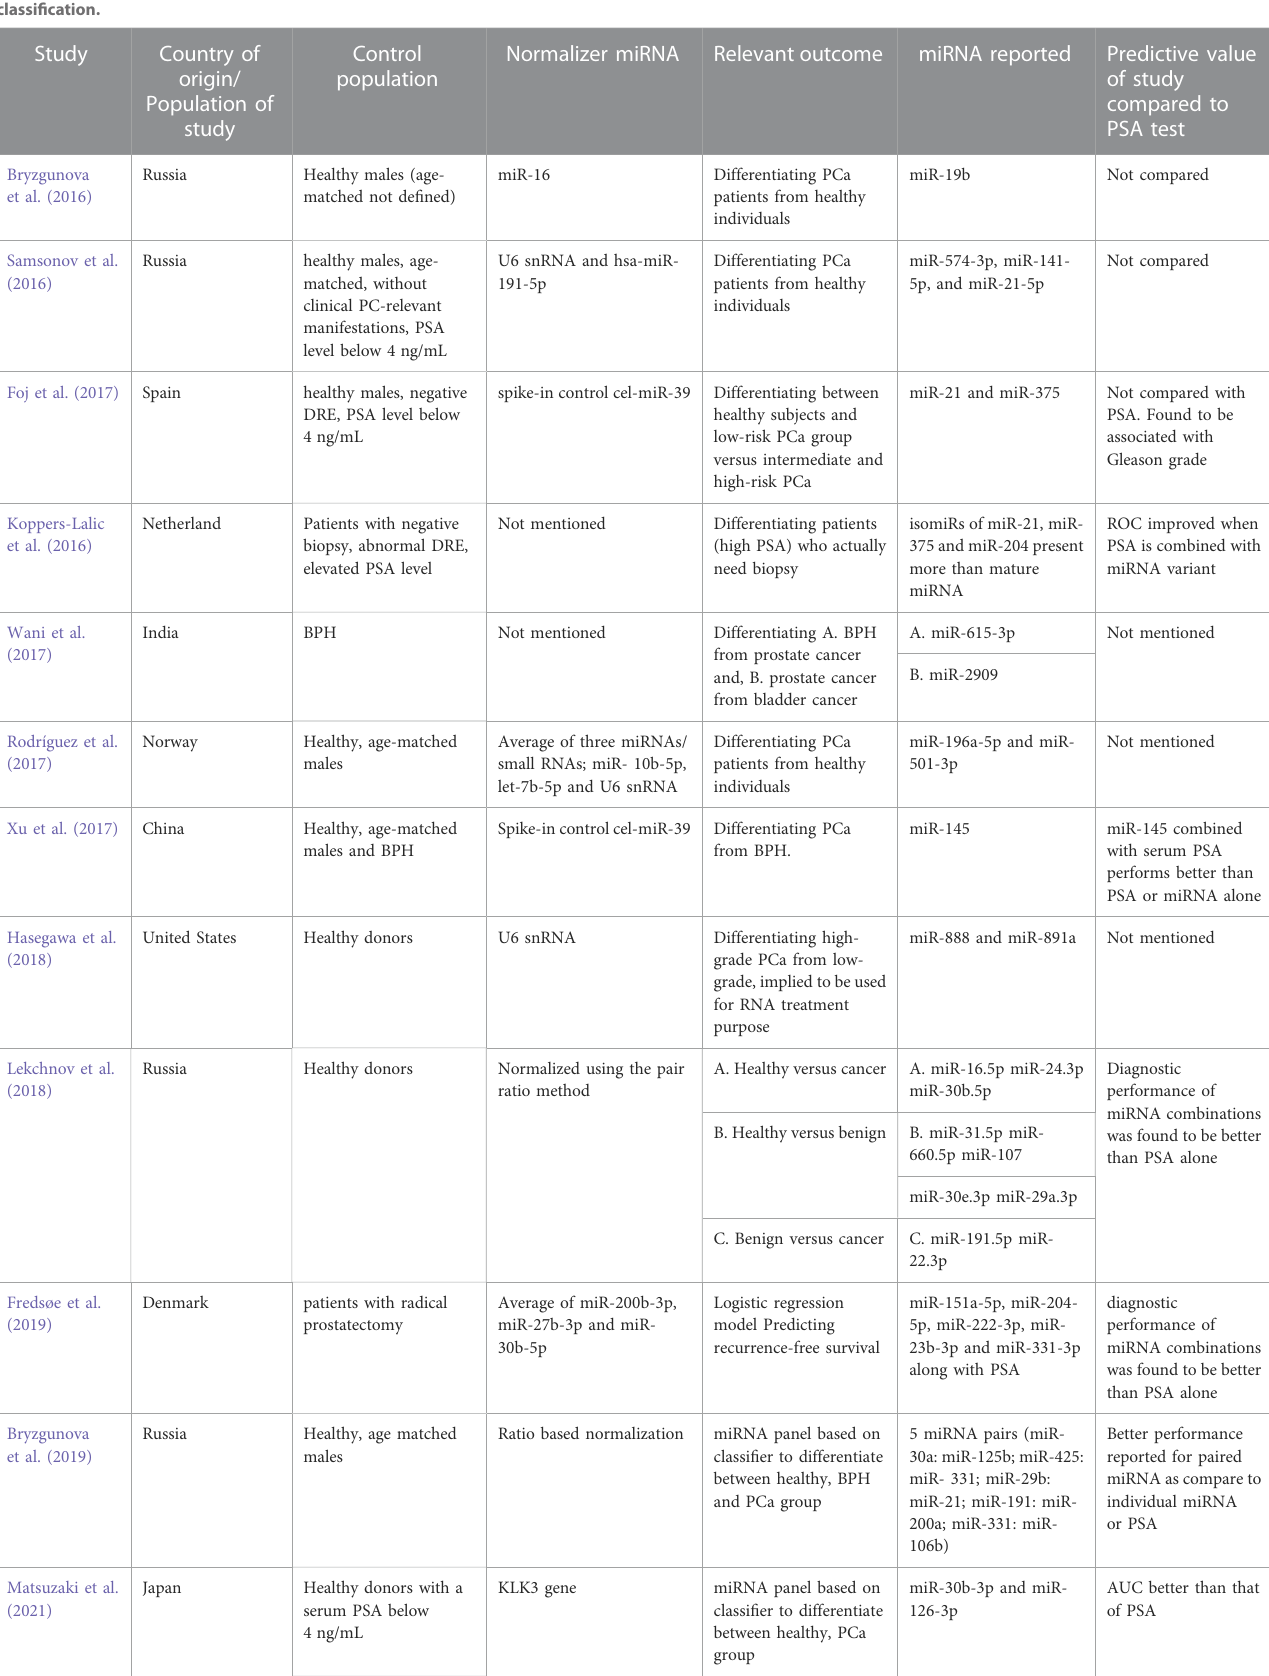
TABLE2Summaryofrelevant studies andurinary-extracellularvesicles miRNAs thatthey haveproposedas potential biomarkersforPCa diagnosis, prognosis andrisk classi fi